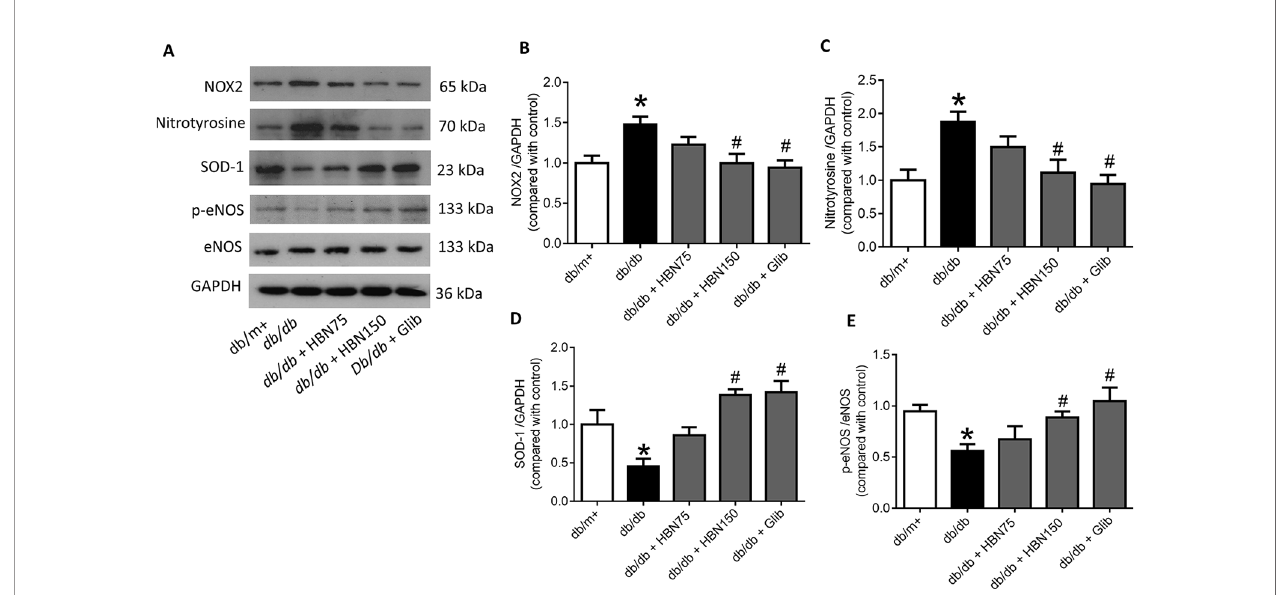
FIGURE 7 | Western blot and quantitative data showing proteins in aorta of db/db mice treated with hydrolyzed bird nest (HBN, 75 and 150 mg/kg), and glibenclamide (1 mg/kg) for four weeks. Results are means + SEM of six separate experiments. *P< 0.05 compared to db/m+; # P < 0.05 compared to